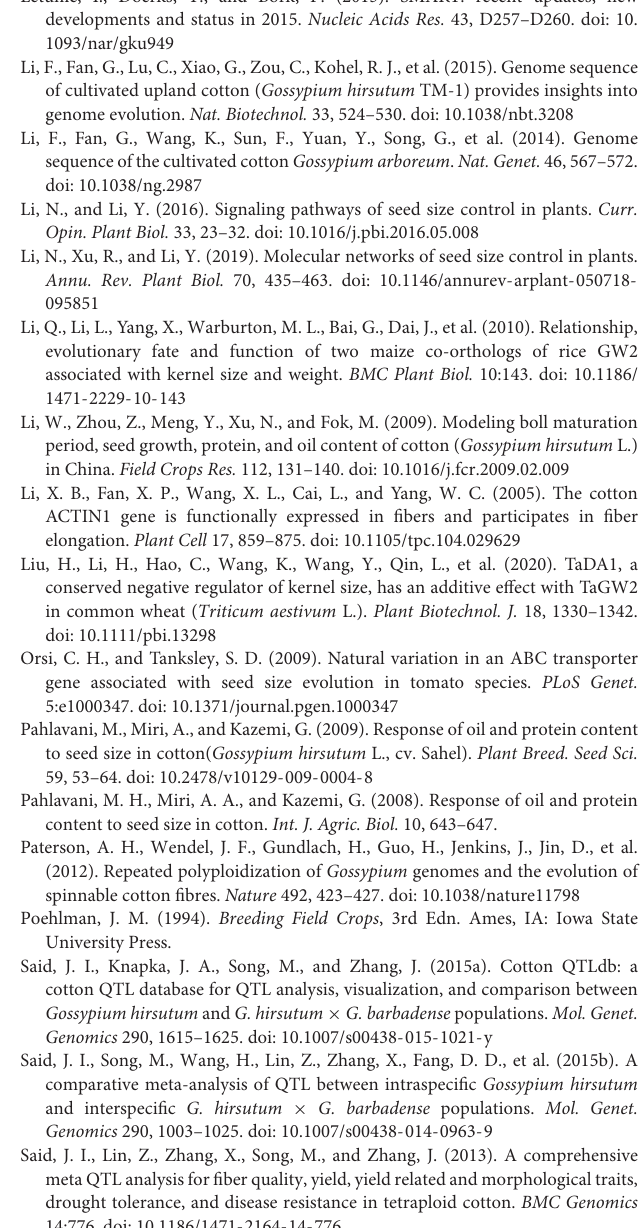
Supplementary Figure 1 | Chromosomal localization of GW2- like genes in Gossypium . All GW2 -like genes were mapped onto chromosomes of G. arboreum (A) , G. raimondii (B) , G. hirsutum (C) , and G. barbadense (D) . The scale represents megabases (Mb). Supplementary Figure 2 | Expression profiles of GW2 -like genes in G. hirsutum TM1 and G. barbadense Hai7124. (A) Expression patterns of GhGW2 -like genes. (B) Expression patterns of GbGW2 -like genes. Supplementary Figure 3 | A co-localization analysis of GhGW2 -like genes with seed size quantitative trait loci (QTLs). GhGW2 -like genes and co-localized QTL are shown in